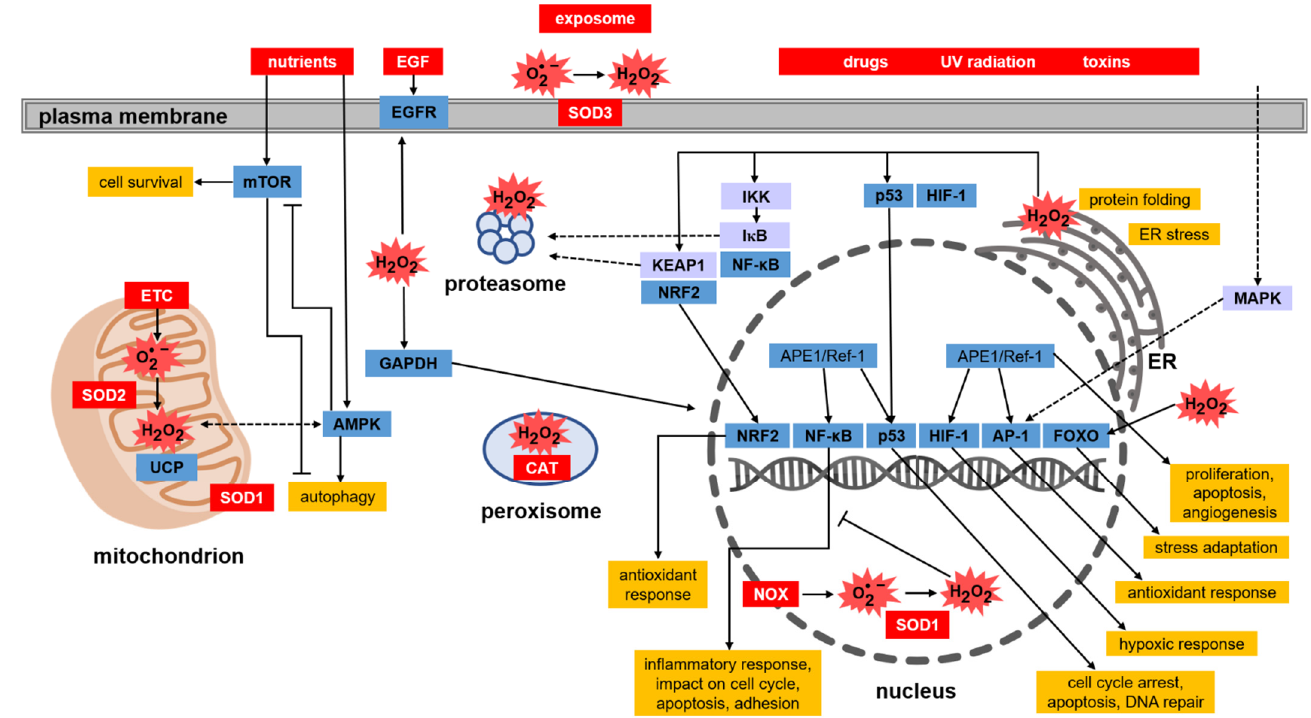
Figure 4. Signalling dependent on the redox status of the cell. Cellular enzymes constitutively or in response to exogenous triggers stimulate the production of ROS (red), which then affect various molecular targets (blue) modulating biological activities (yellow). The action of ROS is pleiotropic and includes the regulation of stress adaptation (including the antioxidant response), inflammatory response, cell death and metabolic adaptation (continuous arrows). A detailed description of the mechanisms is included in the text of chapter 2. The dashed arrows indicate intermediate processes. The